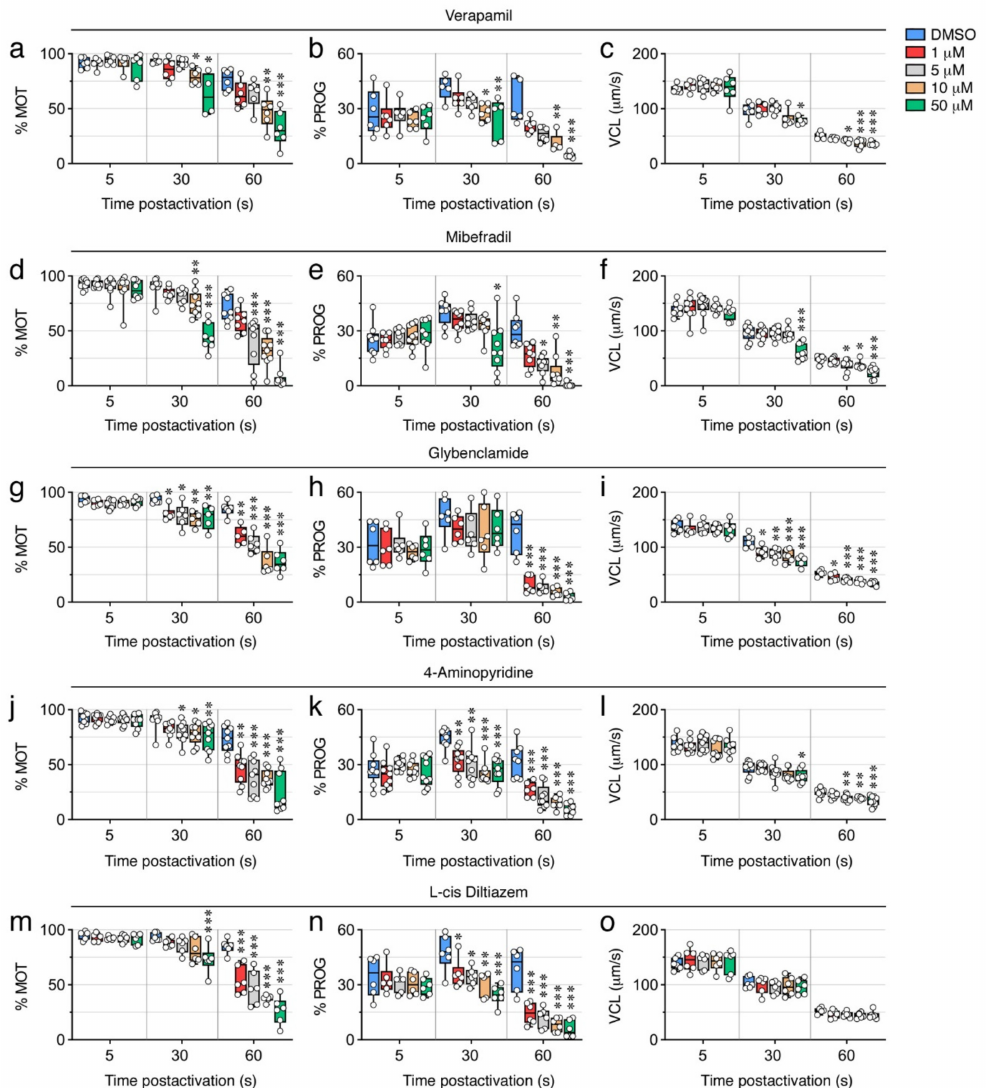
Figure 7. Inhibition of seabream sperm motility by blockers of Ca 2+ channels, ATP-sensitive and voltage-dependent K + channels, and CNG channels. ( a – o ) Dose-response inhibition of the percentage of motility and progressivity (% MOT and % PROG, respectively) and curvilinear velocity (VCL) at 5, 30 and 60 s post activation induced by the different ion channel blockers as indicated. Control spermatozoa were treated with 0.5% DMSO. In all panels, the data points ( n = 6–8 males, one ejaculated per male) are presented as box and whisker plots/scatter dots with horizontal line (inside box) indicating median and outliers. Statistical differences were measured by one-way ANOVA (*, p < 0.05; **, p < 0.01; ***, p < 0.001, with respect to DMSO-treated